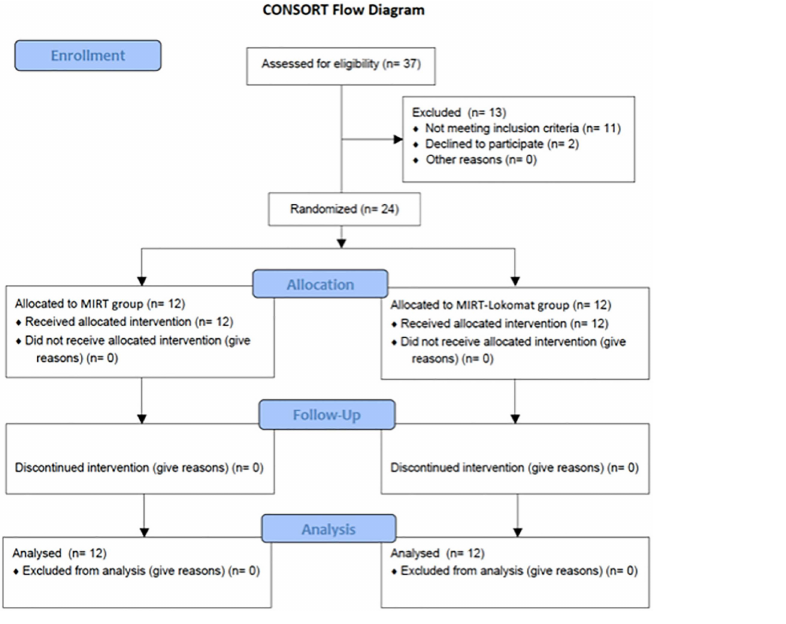
Fig 1. CONSORT flow